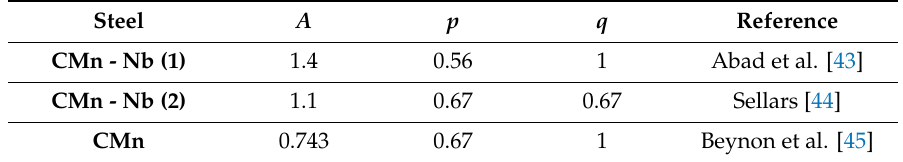
Table 6. Parameters proposed for the calculation of the recrystallized grain size for di ff erent steels using equation